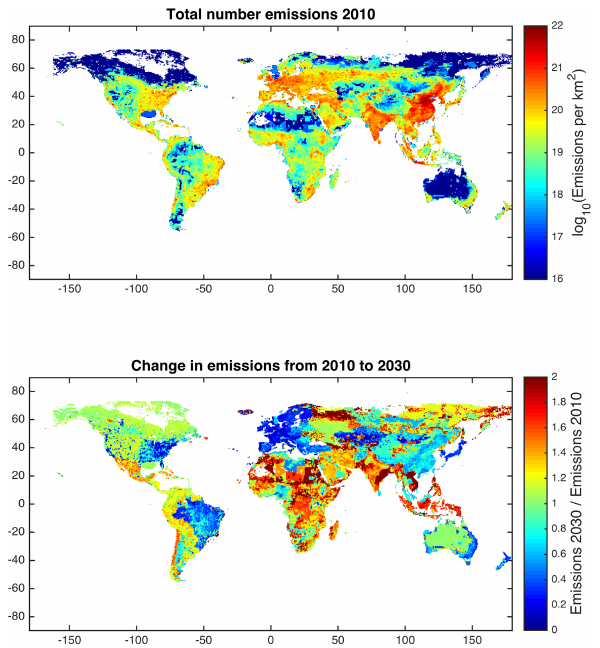
Figure 5. Spatial distribution (in 0.5 ◦ × 0.5 ◦ grid) of global continental anthropogenic particle number emissions in units km − 2 year − 1 (upper panel) and predicted relative change in par- ticle number emission from 2010 to 2030 (lower panel). The grid- ded emissions are available from http://www.iiasa.ac.at/web/home/